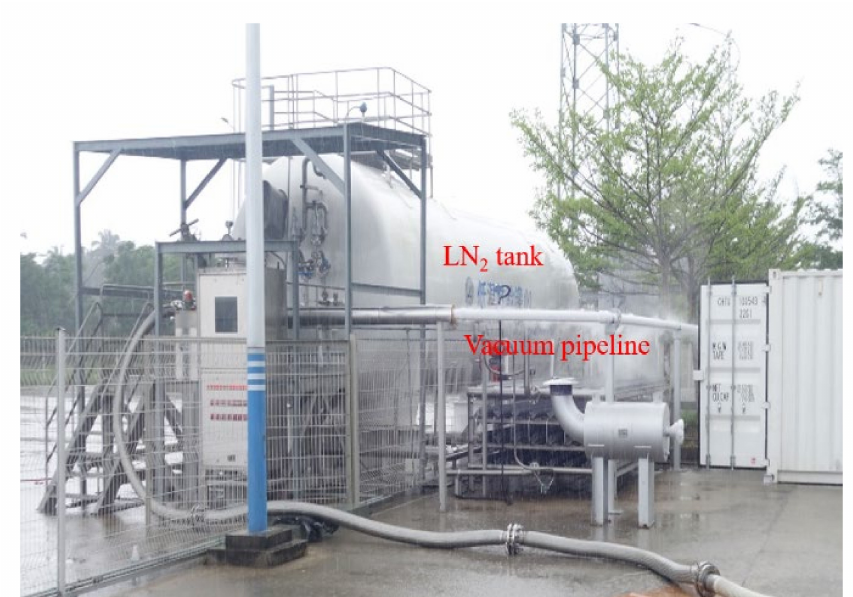
Figure 3. Image of the liquid nitrogen vacuumed subcooling test set.